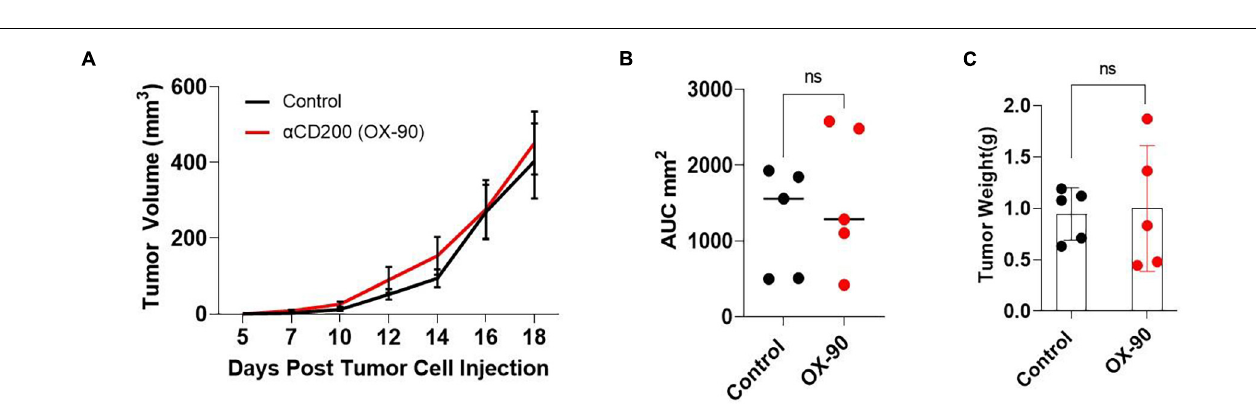
FIGURE 4 | CD200 blockade using a monoclonal antibody failed to inhibit tumor growth. (A) Tumor growth kinetics. Yumm1.7 cells were injected into each mouse s.c. at a dose of 5 × 10 5 /mouse. Mice were treated with anti-CD200 antibody (OX-90) at a dose of 250 µ g/mouse or vehicle i.p. every 3 days when tumors were palpable. Tumor growth was monitored by measuring tumor length and width every 2 days. Growth kinetics (changes of tumor volume over time) of individual tumors are shown. (B) Area under the curve (AUC) was calculated based on the tumor volume data shown in (A) . (C) Tumors isolated from OX-90 and vehicle treated mice were weighted at the end of the experiment. Data shown represents three experiments with similar results. Ns: not significant by two sided Student’s t -test.